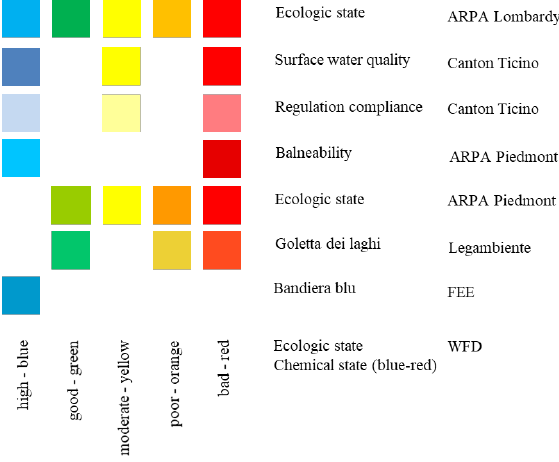
Figure 2. Collection of the colours used by the local authorities in web services about different aspects of water